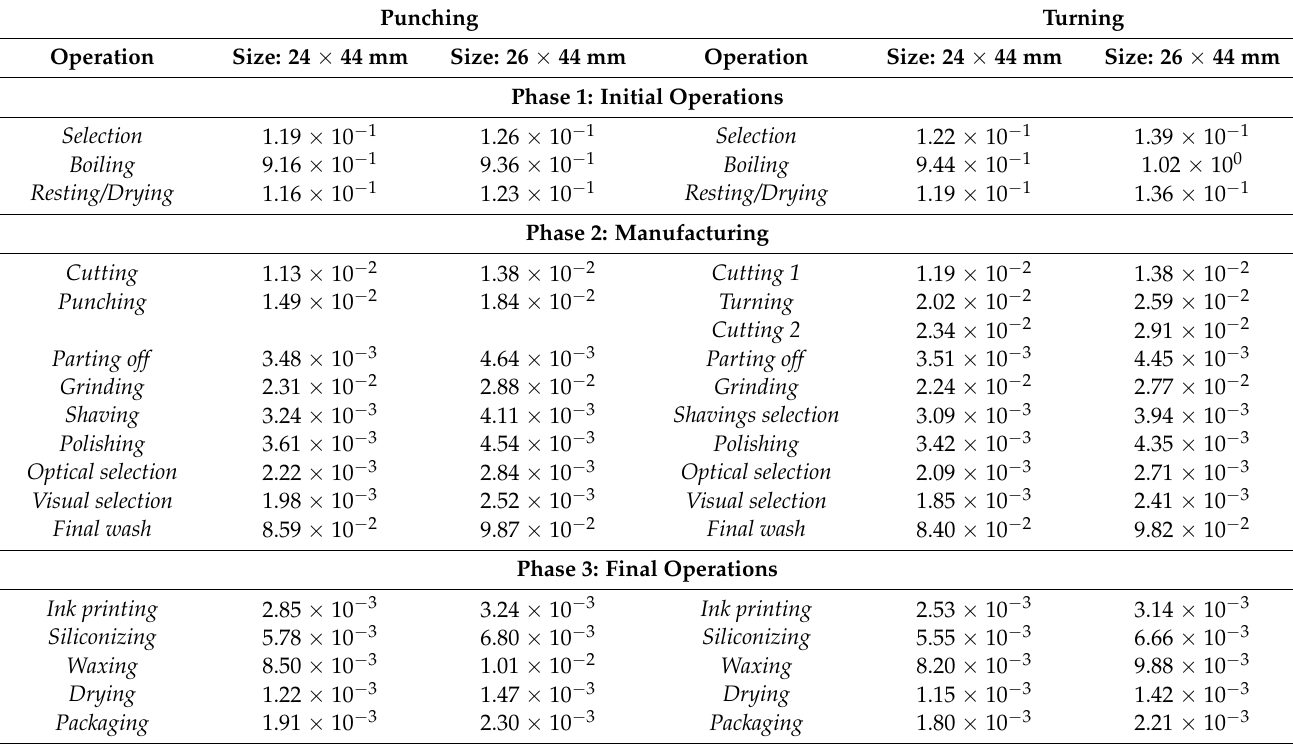
Table 6. Environmental impact by phase (kg CO 2 eq/kg of natural cork